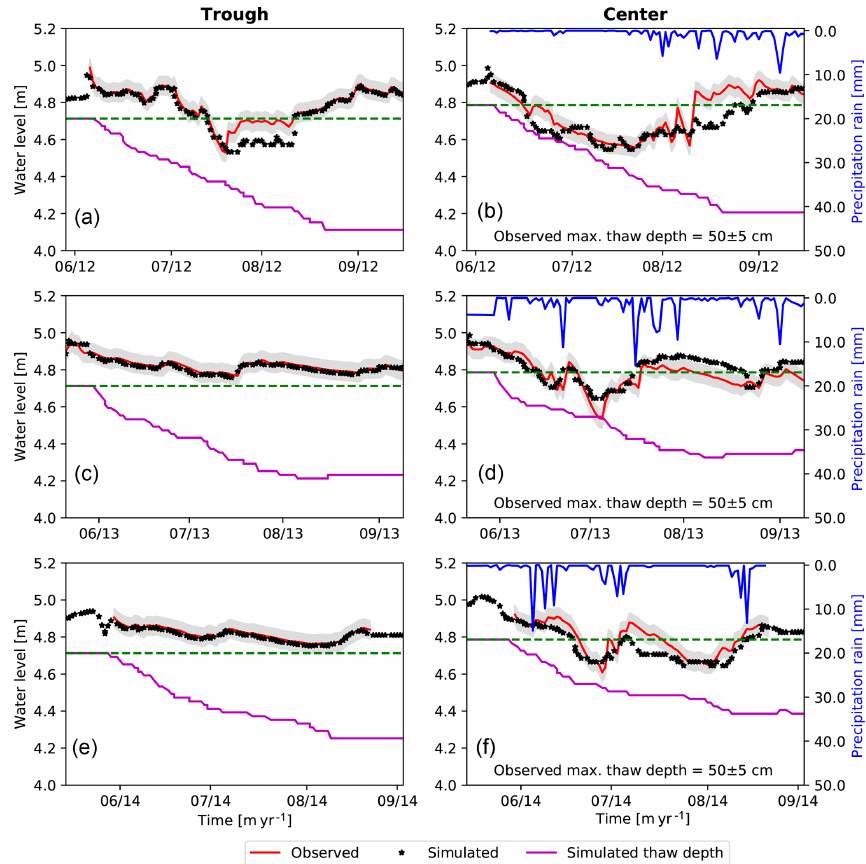
Figure 5. Comparison of simulated and observed water table in (a, c, e) the trough and in (b, d, f) the center for the summers of the years 2012 to 2014. Rows correspond to different years. Blue lines (b, d, f) are the rain